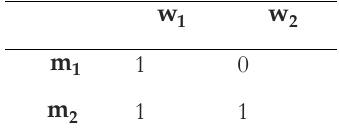
Table 4. Input information of